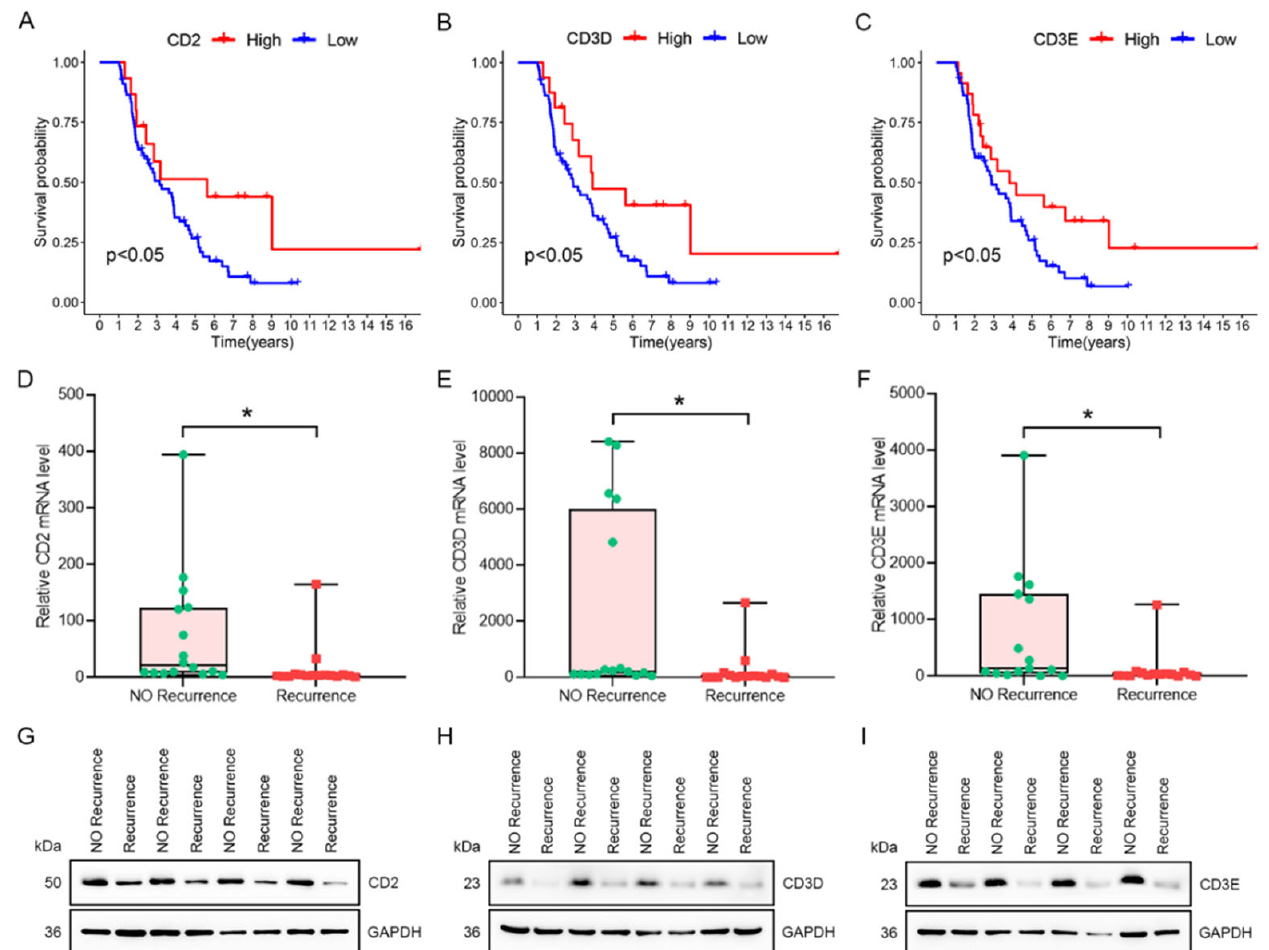
Figure 10. Verification of the prognostic characteristics of immune hub genes in the ICGC cohort and independent cohort. ( A – C ) KM survival curve of patients grouped according to the expression of CD2 ( A ), CD3D ( B ), and CD3E ( C ) in the ICGC database. ( D – F ). CD2 ( D ), CD3D ( E ), and CD3E ( F ) mRNA levels in tumor tissues from patients with and without recurrence. ( G – I ). CD2 ( G ), CD3D ( H ), and CD3E ( I ) protein levels in tumor tissues from patients with and without recurrence. * p < 0.05.